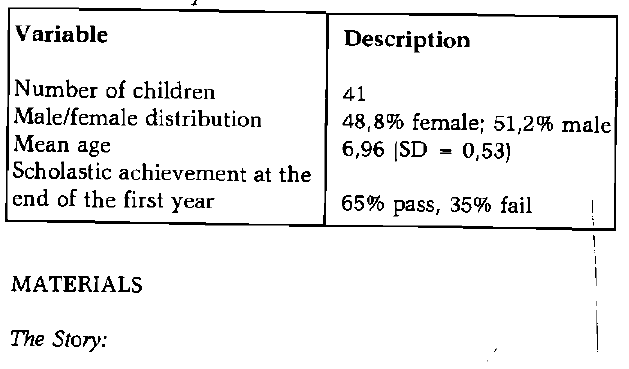
Table 1: Description of subjects at the end of their